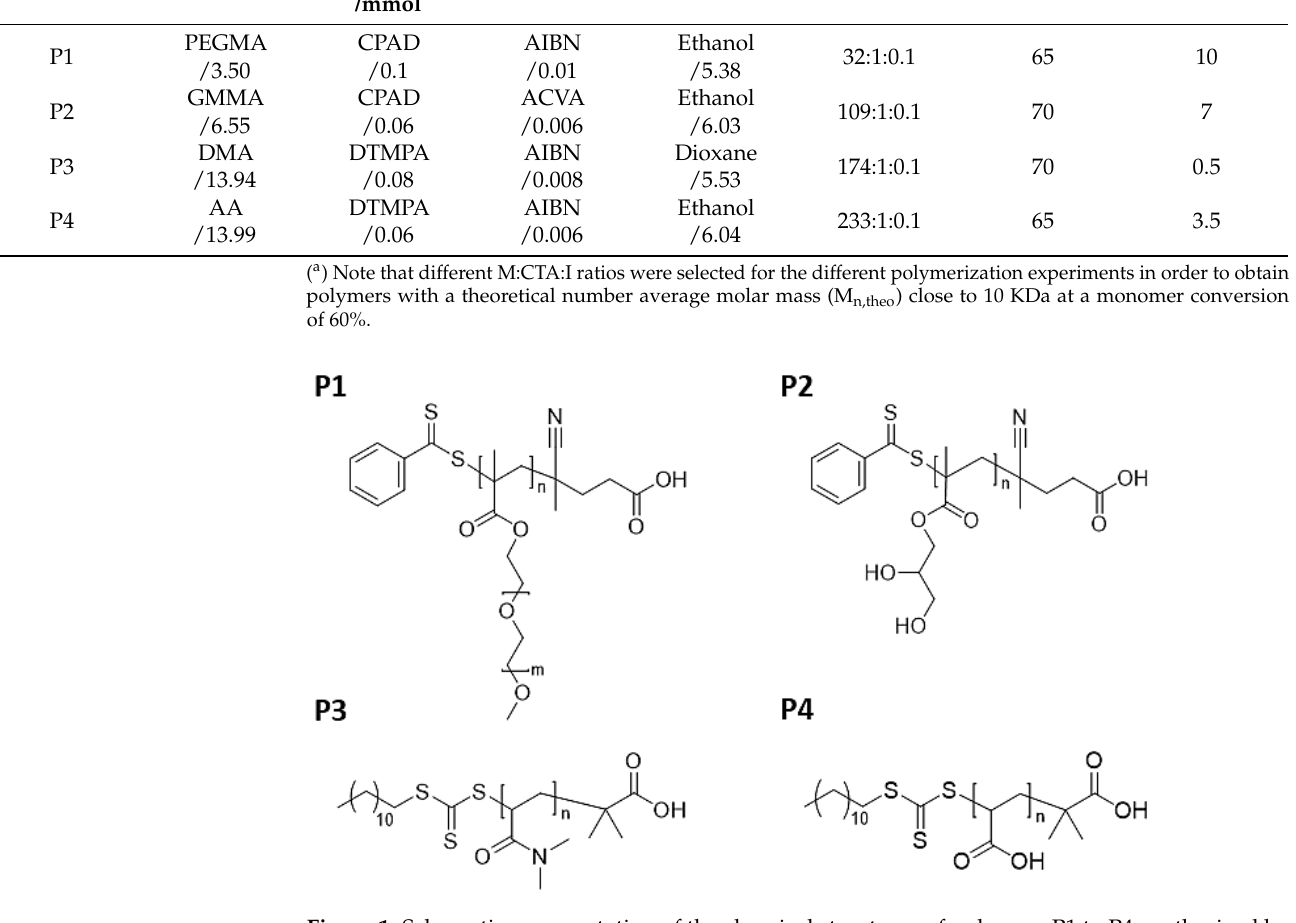
Table 1. Summary of reaction conditions for the synthesis of polymers P1 to P4.